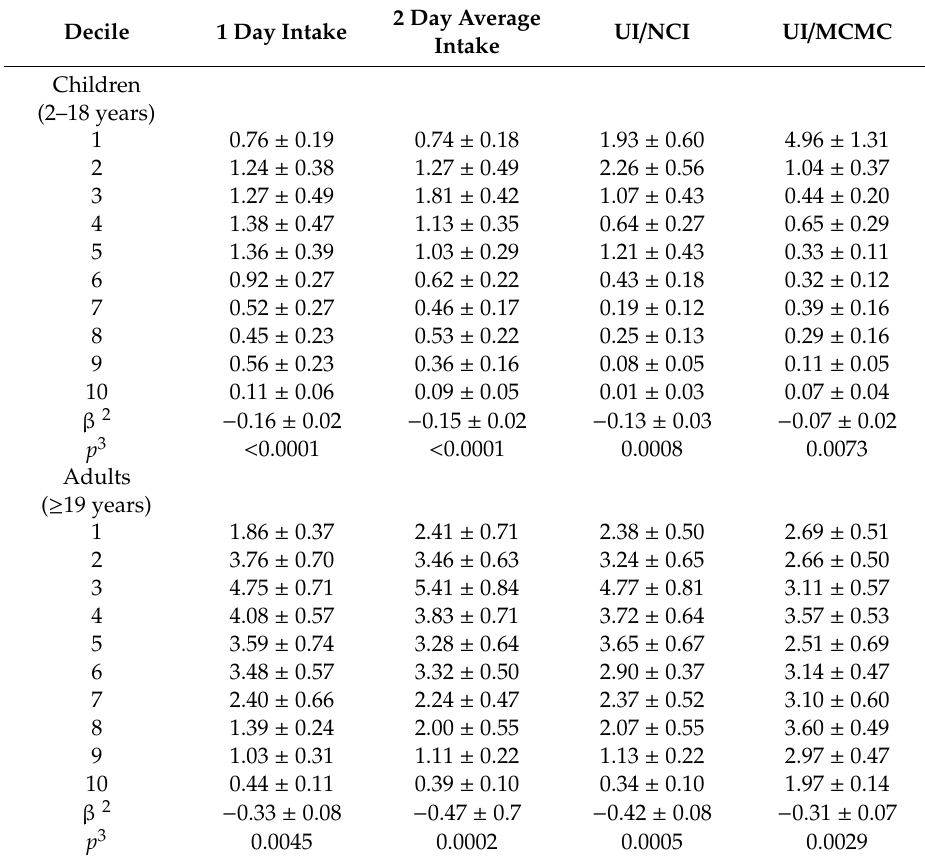
Table 3. Percentage of the population above the Adequate Intake of potassium by deciles of added sugars intake by various methods, the NHANES 2011–2014.